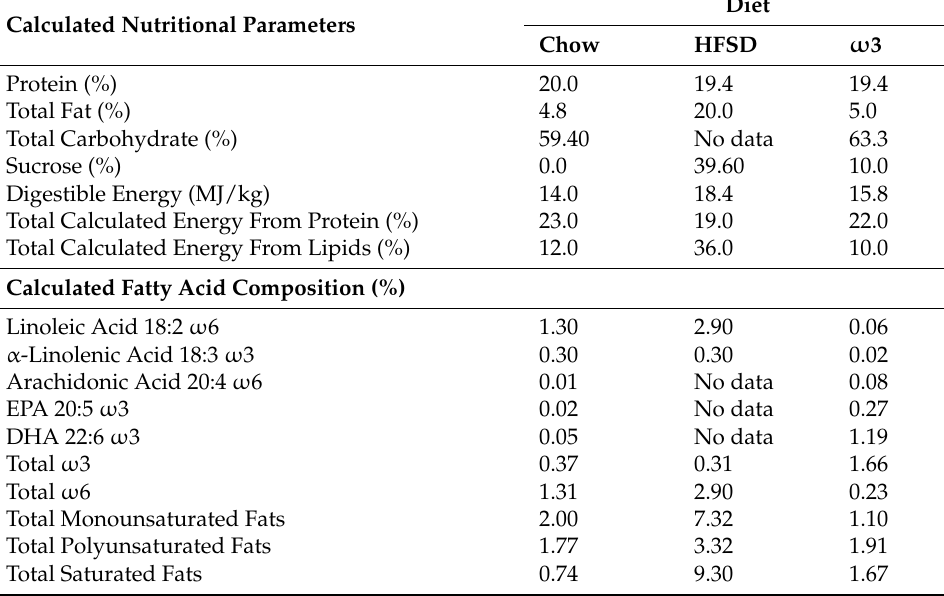
Table 1. Nutritional parameters and fatty acids composition of chow, HFSD and ω 3